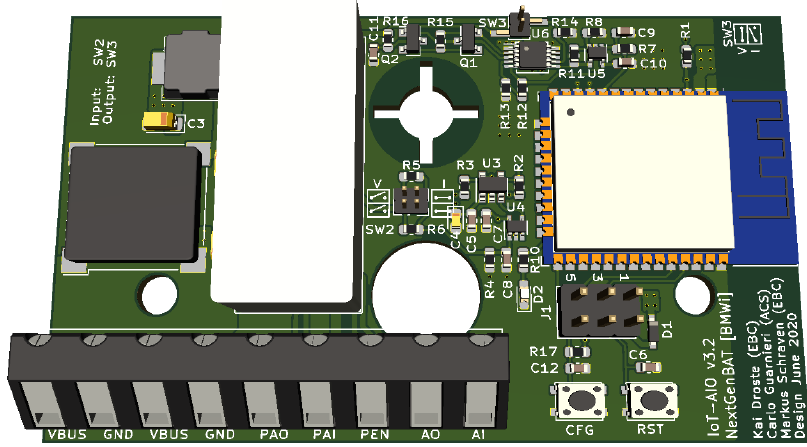
Figure 1. View of the analog gateway (AGW) printed circuit board